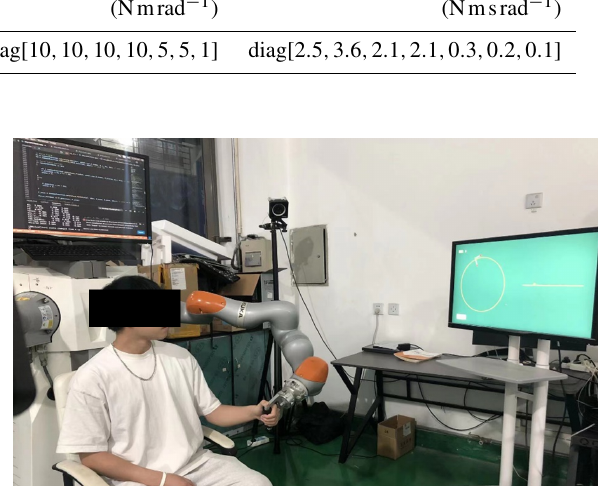
Figure 5. Upper-limb rehabilitation robot with a healthy subject looking at the graphical guidance.